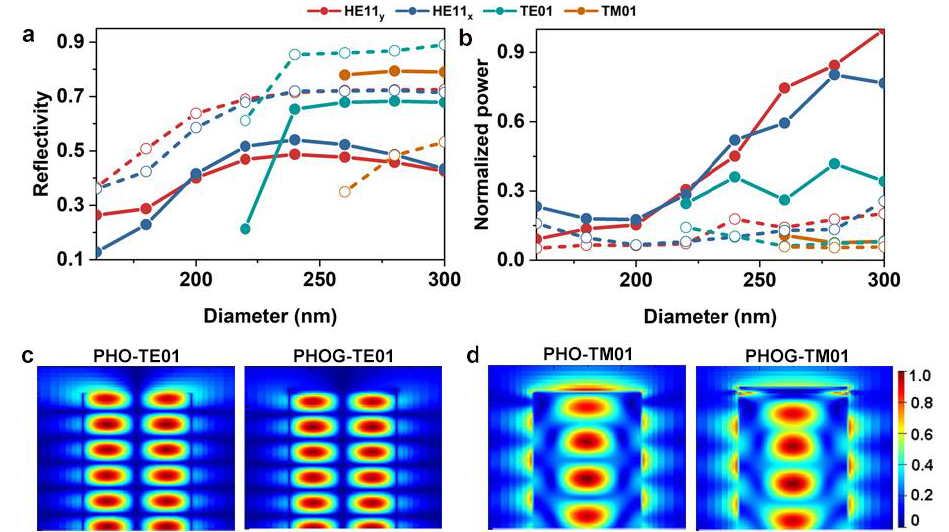
Figure 3. ( a ) Diameter-dependent end facet reflectivity and ( b ) normalized output power of PHO (solid line) and PHOG (dash line) lasers. Electric field intensity profiles at the NW/air interface and NW/Au interface for TE01 ( c ) and TM01 ( d ) mode respectively. The diameter is 300 nm.